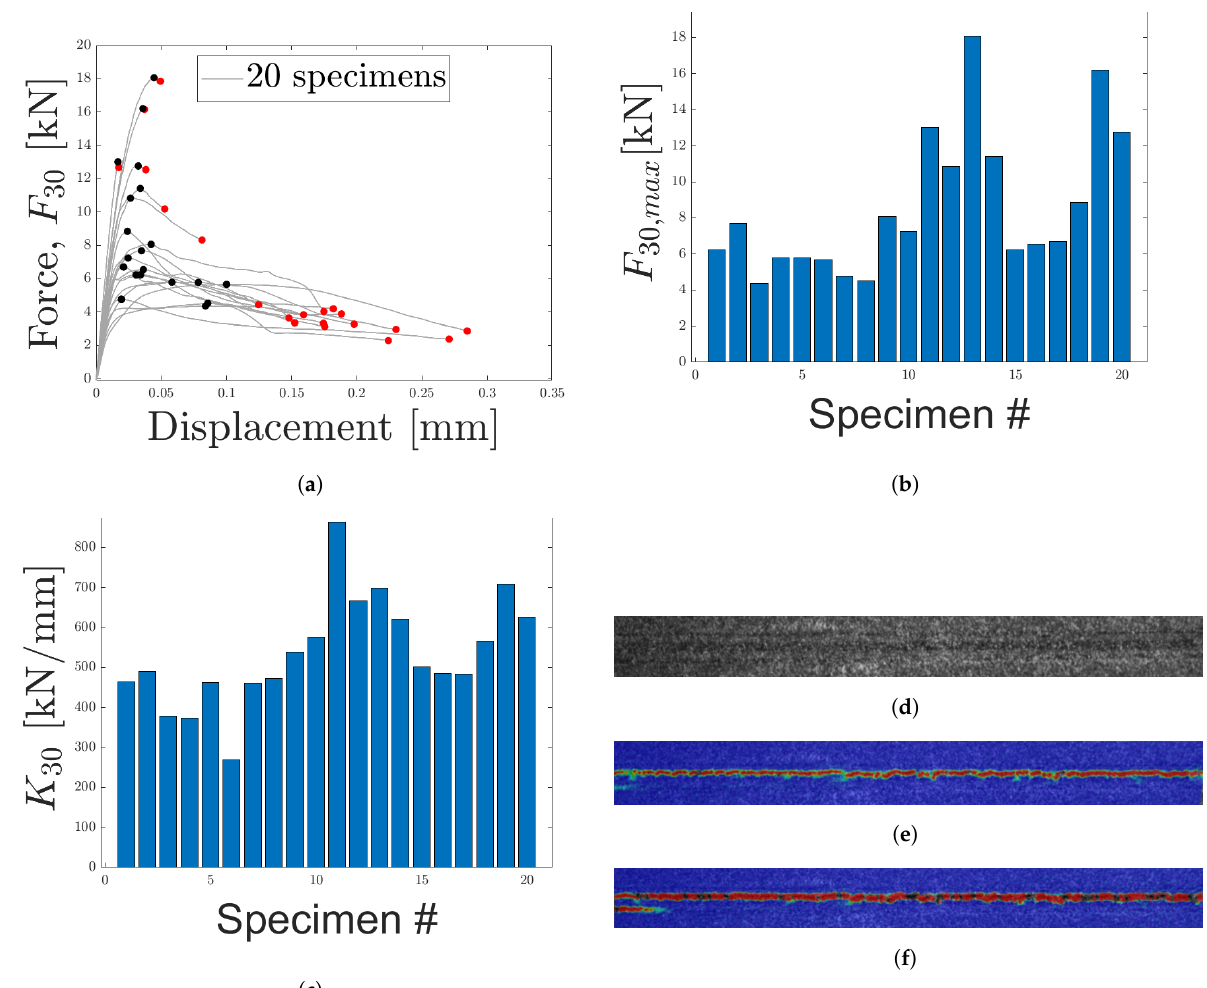
Figure 17. The force–displacement response for LC 4 (30° off axis loading) is presented in ( a ), with maximum force and displacement marked with black and red, respectively. In ( b , c ), maximum force and stiffness are presented. ( d ) contains the speckle pattern for one of the specimens. In ( e , f ), the strain field along the loading direction (before and after fracture), obtained using DIC, is presented.